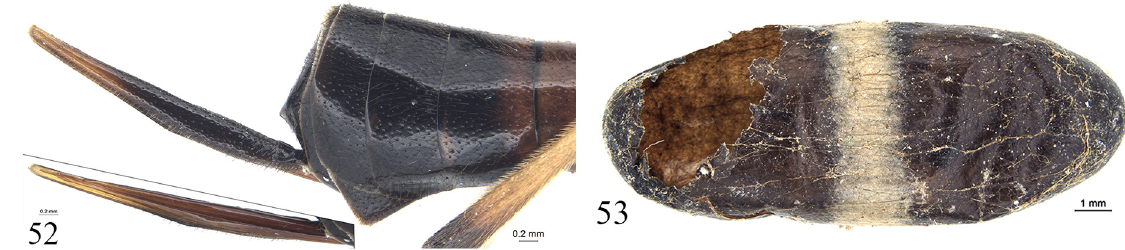
Figs 52–53. Ctenopelma spiraculare Sheng, Sun & Li sp. nov., holotype, ♀ (GSFGPM). 52 . Apical portion of metasoma, lateral view. 53 .